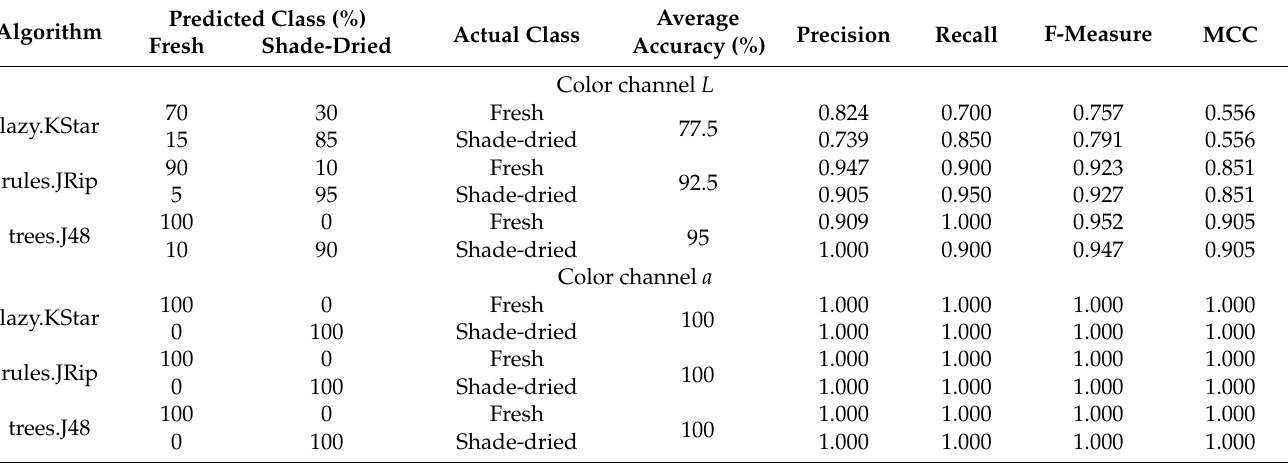
Table 8. The classification of the dorsal side of fresh and shade-dried mint leaves using models including selected image textures from color channels L , a , and b